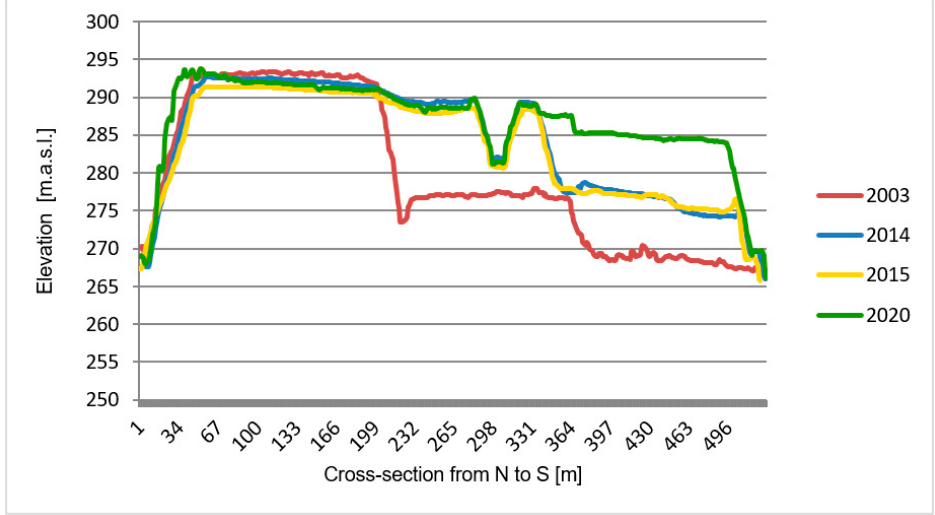
Figure 3. Cross-section N–S with the profiles of dump canopy in period Figure 3. Cross ‐ section N–S with the profiles of dump canopy in period 2003–2020.